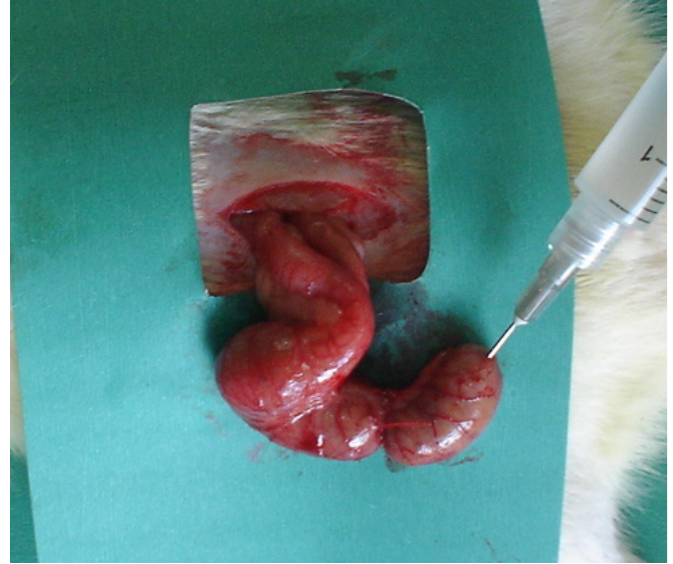
FIGURE 3 - Cecum ligation and distal needle